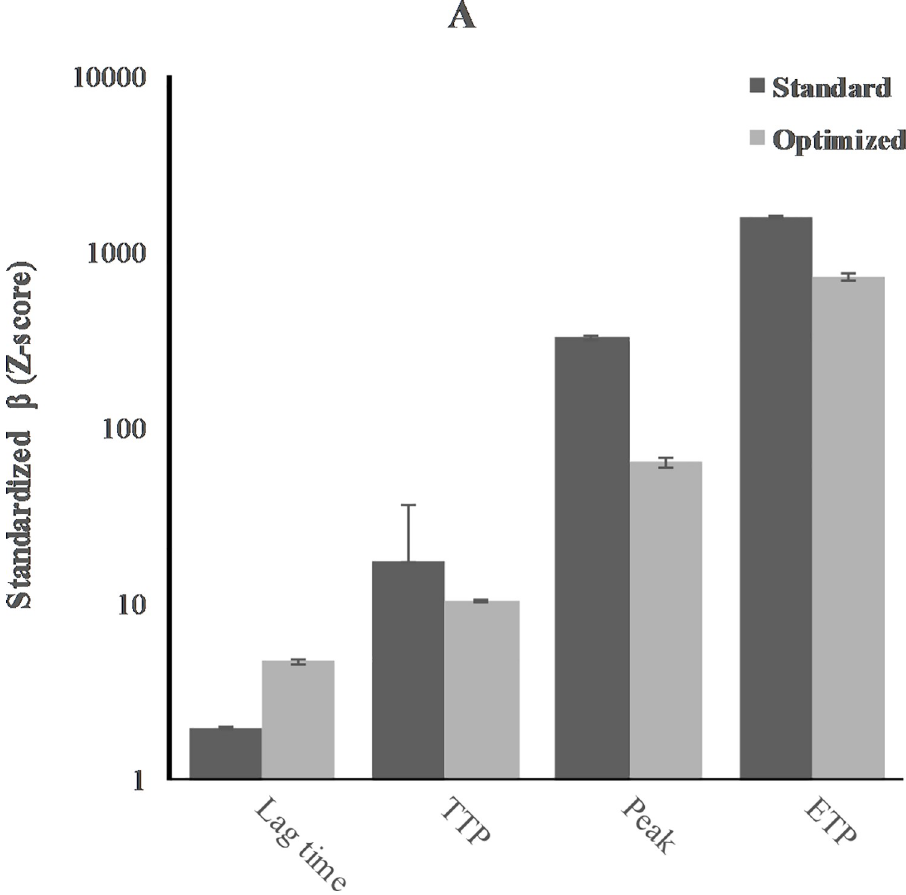
Fig 2. Effect of CTI on assay parameters for